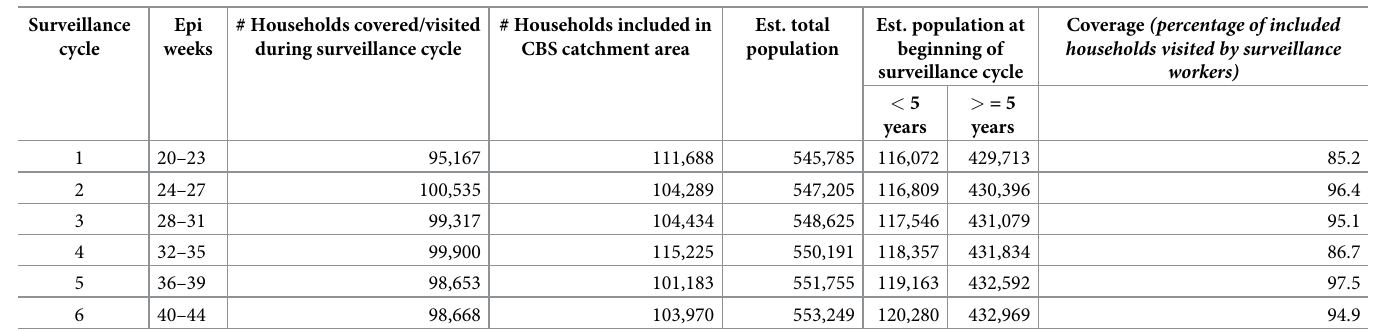
Table 4. Catchment population MSF’s CBS in Cox’s Bazar, Bangladesh, week 20–44, 2019. Surveillance cycle